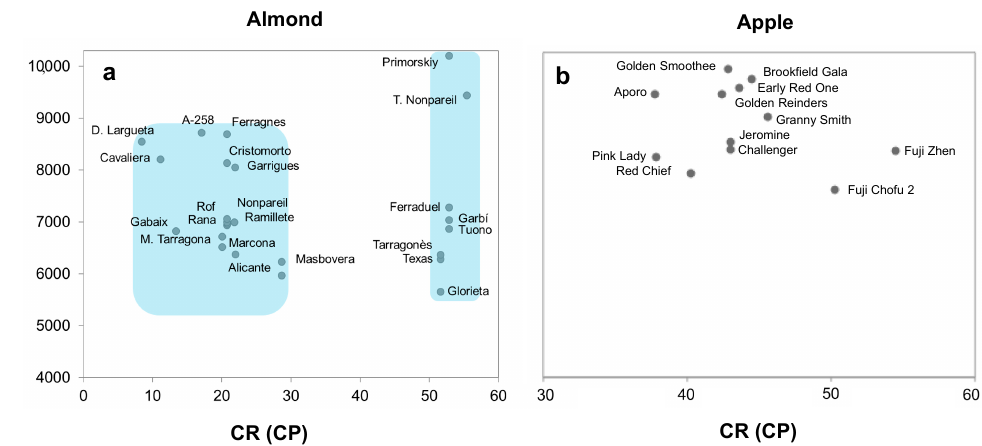
Figure 5. Almond and apple cultivars distribution according to their mean chill (CR) and heat (HR) requirements. Requirements calculated for ( a ) almond cultivars for the period 1979–2015 in Mas de Bover and ( b ) for apple cultivars for 1992–2015 in Mas Badia. GDH and CP stand for growing degree hour and chill portions, respectively.